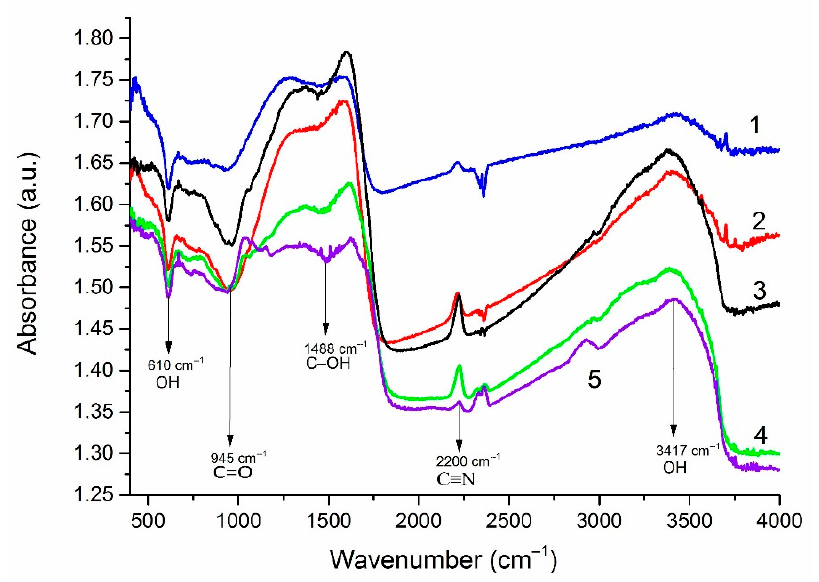
Figure 7. Results of the study of synthesized FLG nanosheets by FTIR spectrometry. The initial